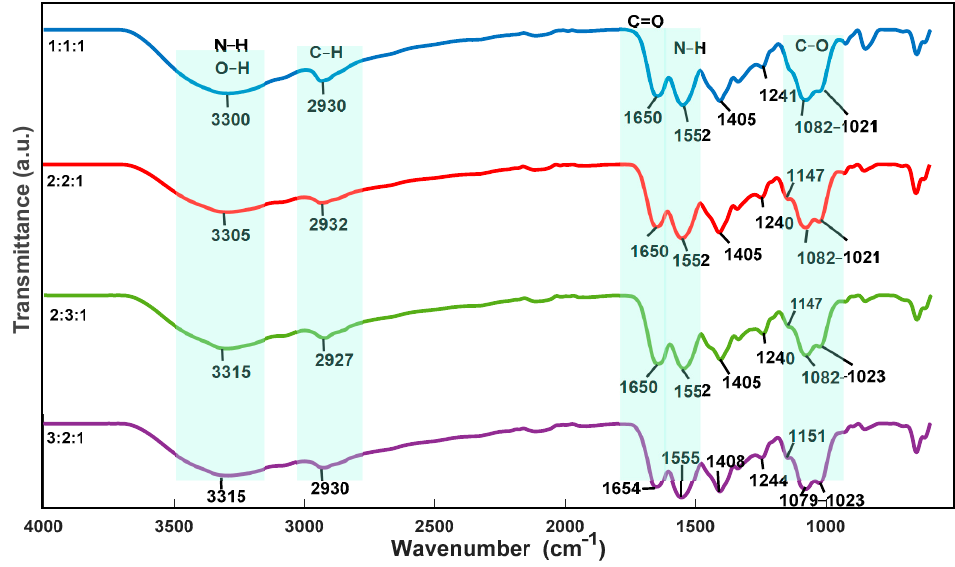
Figure 7. FTIR spectra of ternary blend scaffolds.